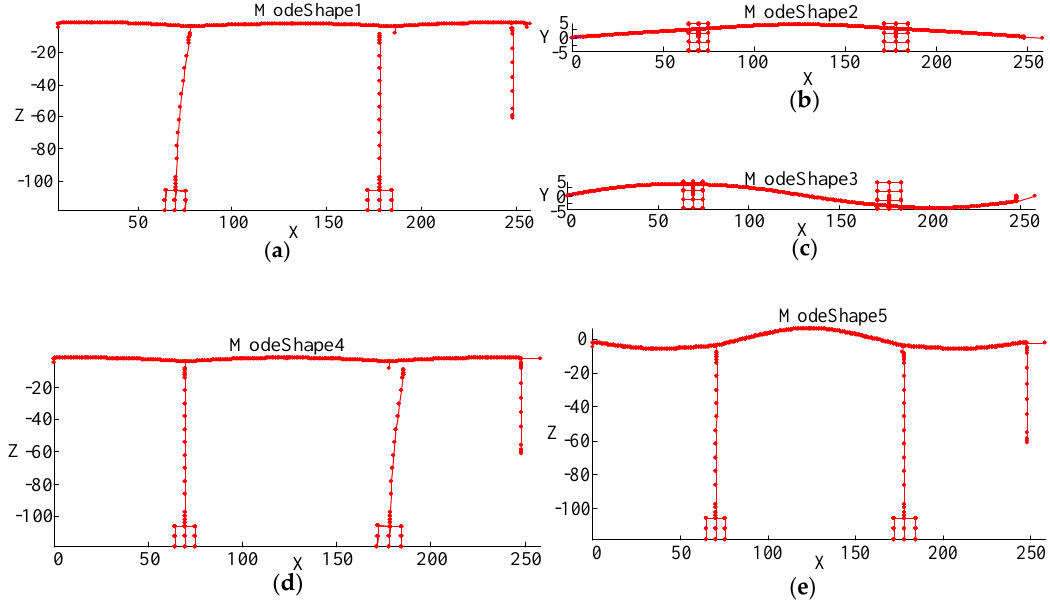
Figure 8. Natural frequencies and corresponding vibration modes: ( a ) Longitudinal bending of fixed pier (f = 0.433Hz); ( b ) 1st transverse bending (f = 0.769Hz); ( c ) 2nd transverse bending (f = 1.026Hz); ( d ) Longitudinal bending of pier 2# (f = 1.191Hz); ( e ) 1st vertical bending (f =1.567Hz).